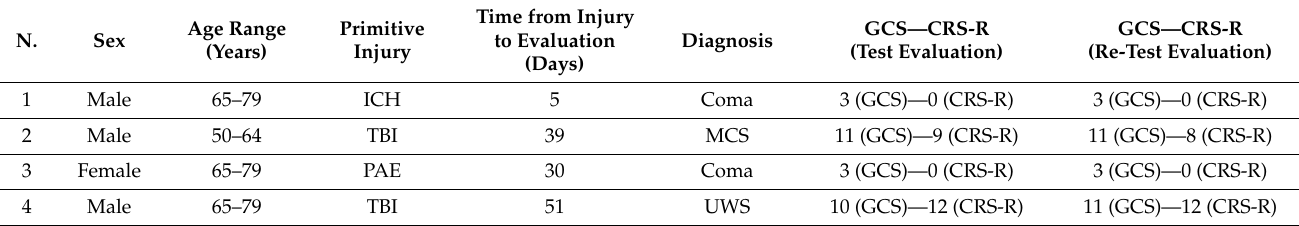
Table 2. Anagraphical and clinical characteristics of included patients for reliability analysis (ICH: Intracerebral Hemorrhage, TBI: Traumatic Brain Injury, PAE: Post-anoxic encephalopathy, IS: Ischemic Stroke: SAK: Subarachnoid Hemorrhage, UWS: Unresponsive Wakefulness Syndrome, MCS: Minimally Conscious State). The diagnosis of the state of consciousness was made using the Glasgow Coma Scale (GCS) and the Coma Recovery Scale—Revised (CRS-R). N. Diagnosis